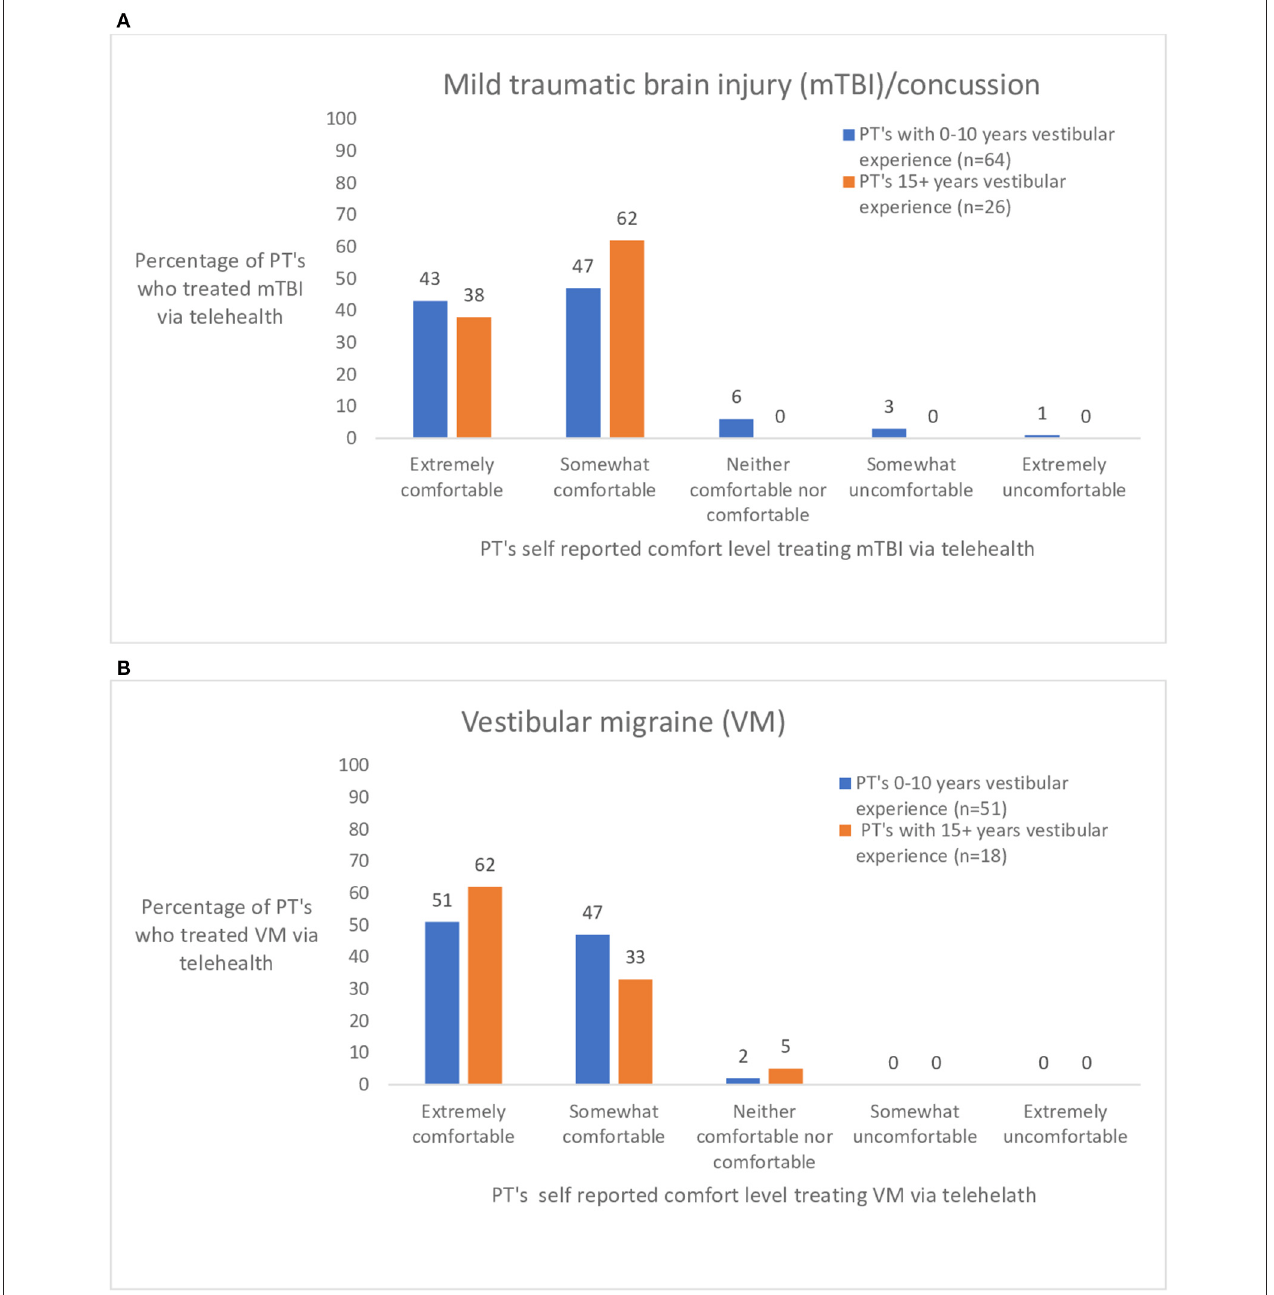
FIGURE 4 | (A,B) Ratings by physical therapists (PT’s) with 0–10 and 15 + years of vestibular experience who treated persons with common central vestibular diagnoses: mild traumatic brain injury/concussion (mTBI) and vestibular migraine (VM) via telehealth. visits were as effective as in-person visits?” ( n = 159). telehealth care during the second and third quarters of